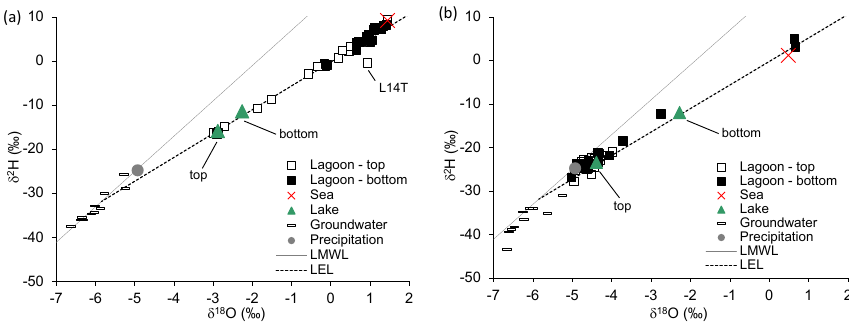
Figure 4. Dual isotope plot for (a) dry season and (b) wet season sampling campaign; LMWL and average precipitation taken from closest station of the GNIP data base i.e.